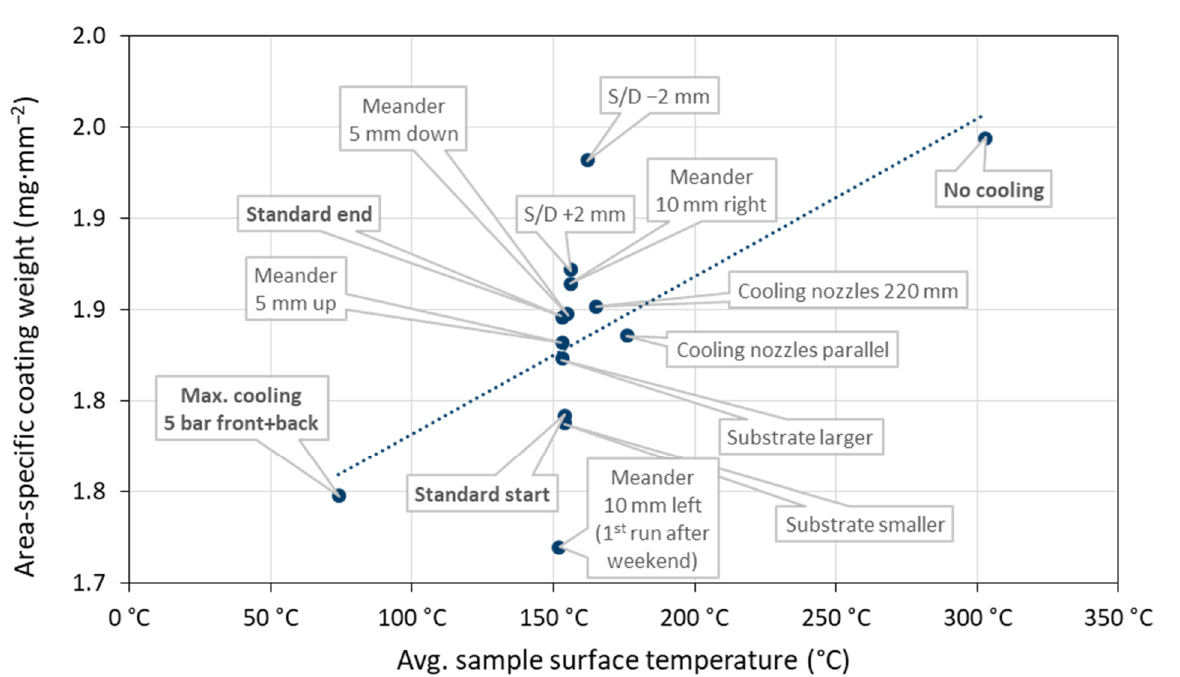
Figure 12. Area-specific coating weights plotted against the time-averaged surface temperature for a series of 14 spray experiments with deliberately varied process parameters.